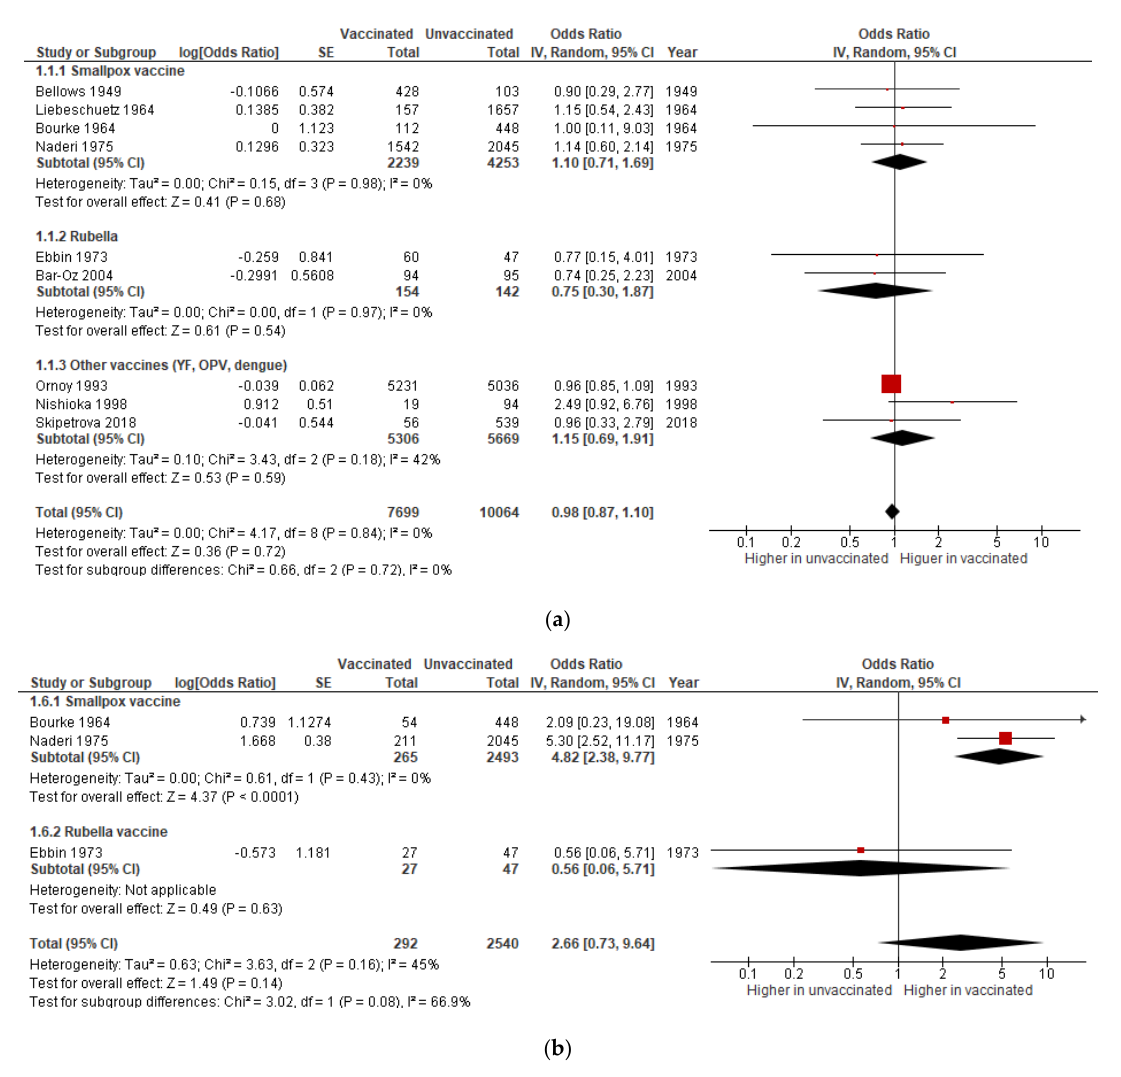
Figure 2. Meta-analysis of the association between maternal immunization and miscarriage. Forest plots showing the effect of vaccination during pregnancy on the odds of miscarriage in all trimesters ( a ) and in the first trimester ( b ), subgrouped by vaccine.